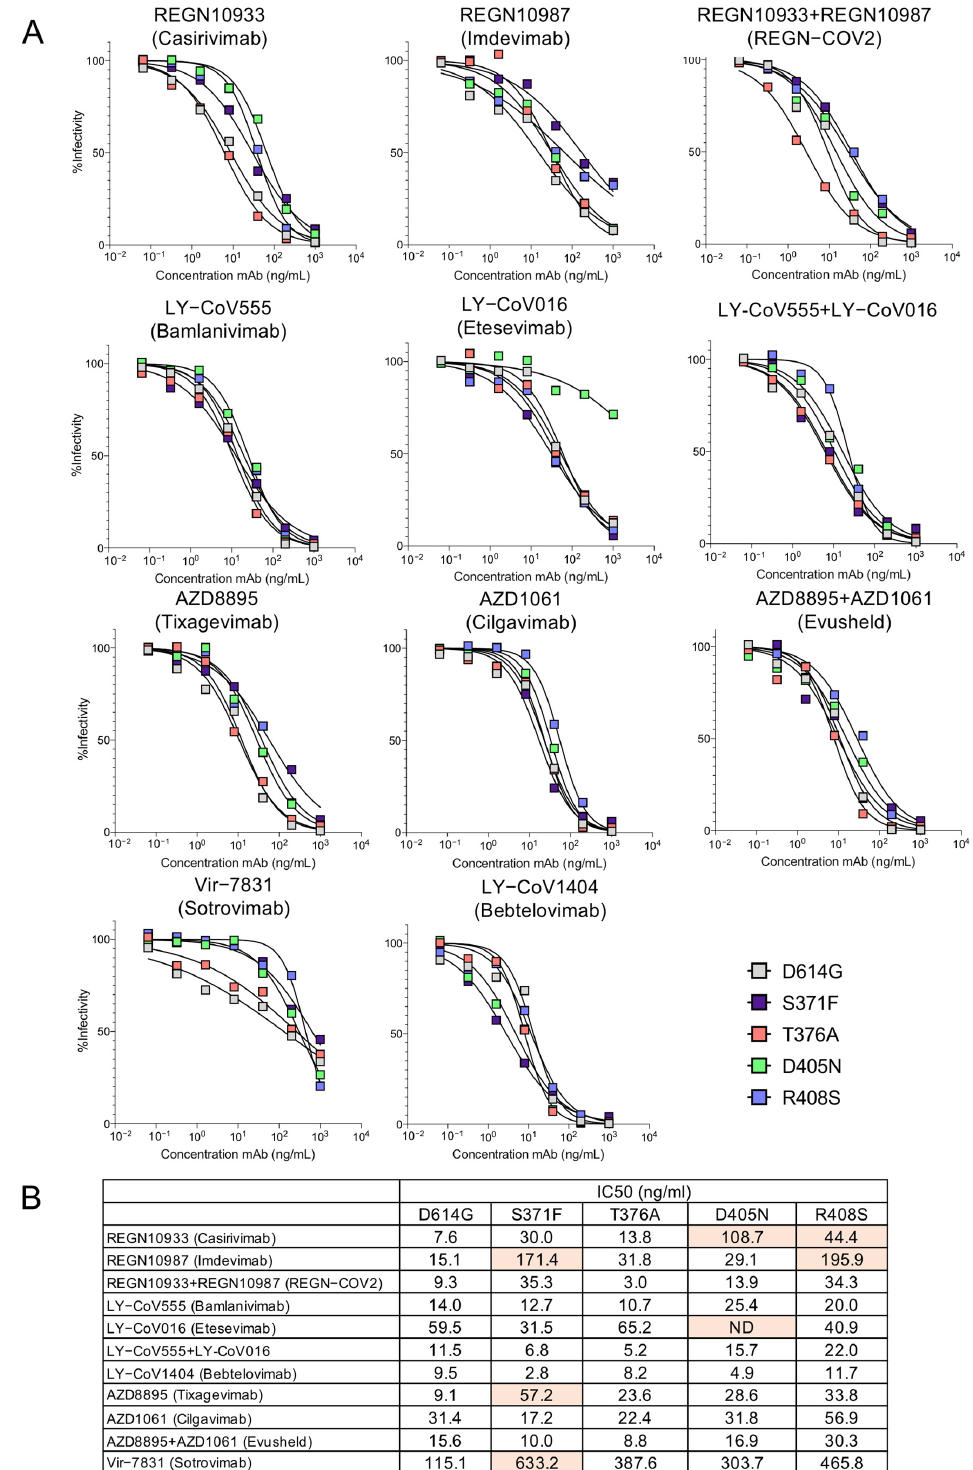
Figure 3. Neutralization of point mutated virus BA.2 by therapeutic monoclonal antibodies. ( A ) Indi- vidual point mutated viruses were treated with 5-fold serially diluted monoclonal antibodies and then used to infect ACE2.293T cells. Luciferase activity was measured after 24 h. ( B ) The IC50 was calculated from the neutralization curves using GraphPad Prism 8 software. Mutations found to cause >5-fold decrease in neutralizing titer are shown in orange. Values that did not approach 50% neutralization were not determined